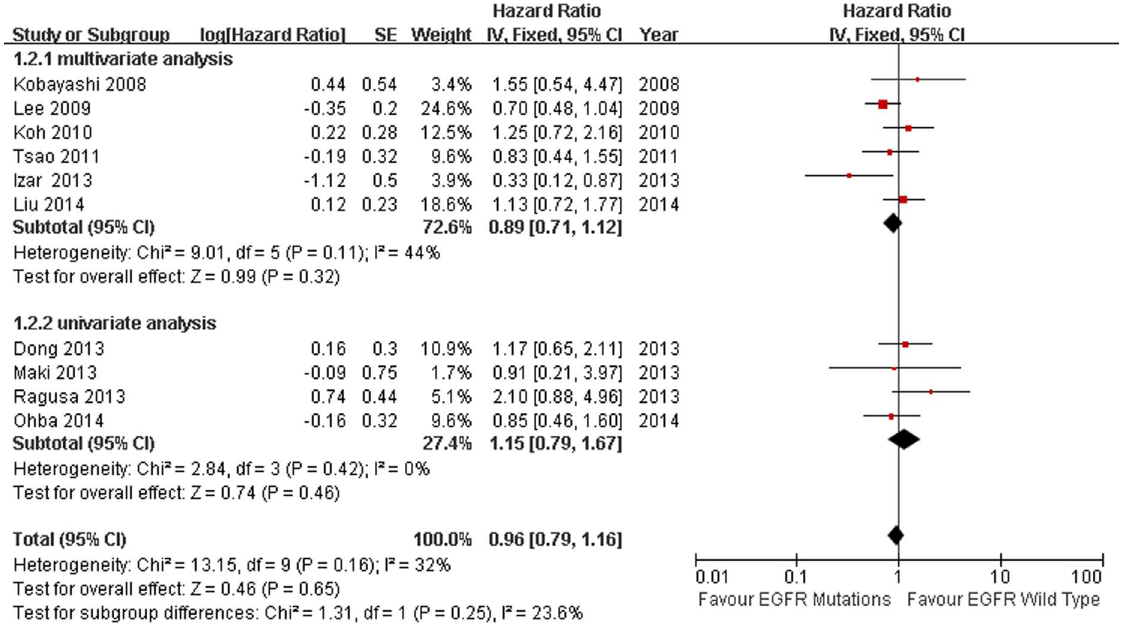
Figure 3. Fixed-effect model forest plot of HR of DFS in statistical analysis method subgroup analysis according to EGFR mutation status. Solid diamond indicates the pooled HR of DFS, square indicates hazard ratio value of each study.